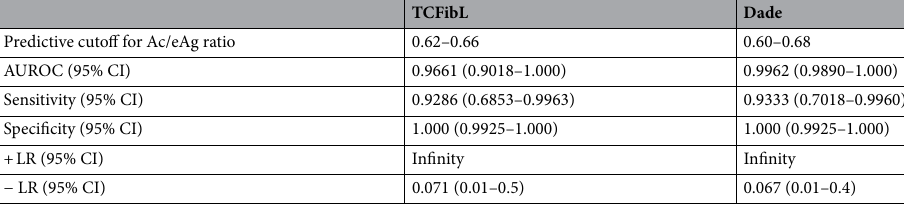
Table 2. Predictive cutoff values and their performance in distinguishing qualitative fibrinogen defects. TCFibL, Thrombocheck FibL reagent; Dade, Dade Thrombin Reagent; AUROC, area under the receiver- operating characteristics curve; LR, likelihood ratio; + LR, positive LR; − LR, negative LR; Ac, functional fibrinogen concentration; Ag, antigenic fibrinogen concentration; eAg, estimated